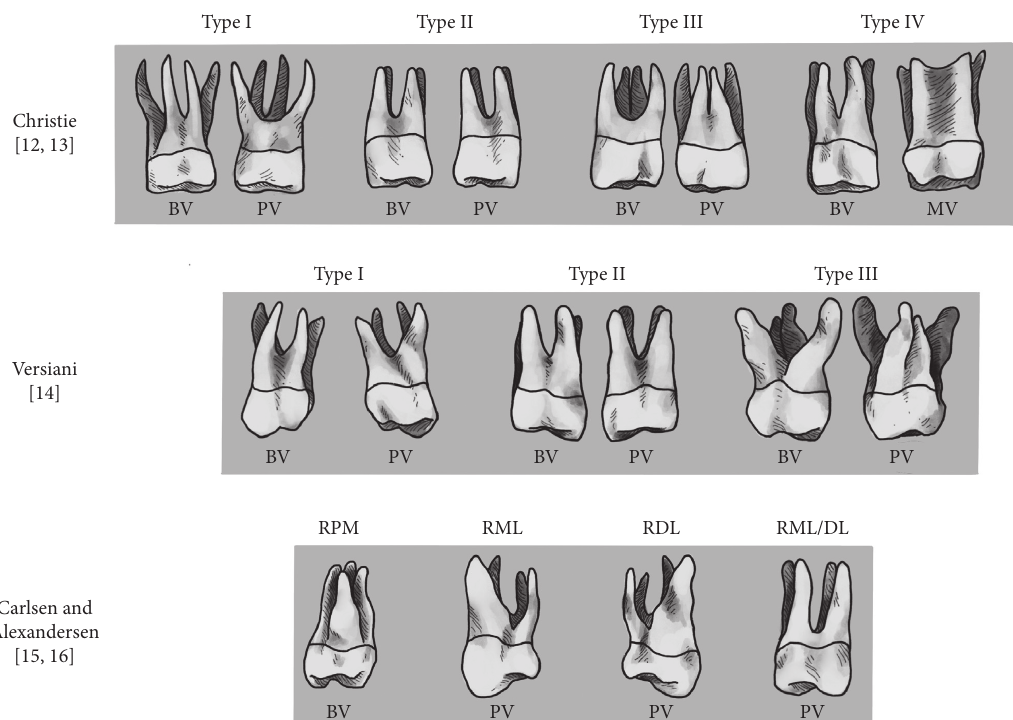
Figure 1: Schematic drawing of radicular classifications of four-rooted maxillary molars modified from [12–16]. Christie classified four- rooted maxillary molars in Type I to Type III based on the radicular shape and the degree of root separation [12]. Type IV was added by Baratto-Filho [13] with a fused mesiobuccal and mesiopalatal root. Versiani’s modified radicular classification [14]. Carlsen and Alex- andersen defined and named additional radicular structures upon their buccal or palatal location and according to their affinity to the dental crown. BV:buccal view, PV:palatal view, MV:mesial view, RPM:radix paramolaris, RML:radix mesiolingualis, RDL:radix distolingualis, RML/DL:radix